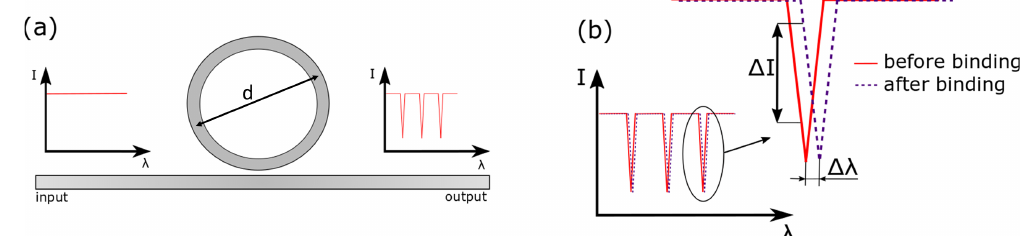
Figure 1. ( a ) Schematic representation of a silicon-on-insulator ring resonator. According to the resonance condition, only selected wavelengths can propagate in the ring and distinct resonance peaks appear in the output spectrum. Typical ring diameter d range from 20 µ m to 100 µ m. ( b ) Molecular binding takes place if a sample of the analyte gets in touch with the adsorbed layer on top of the silicon waveguide leading to a resonance wavelength shift ∆ λ